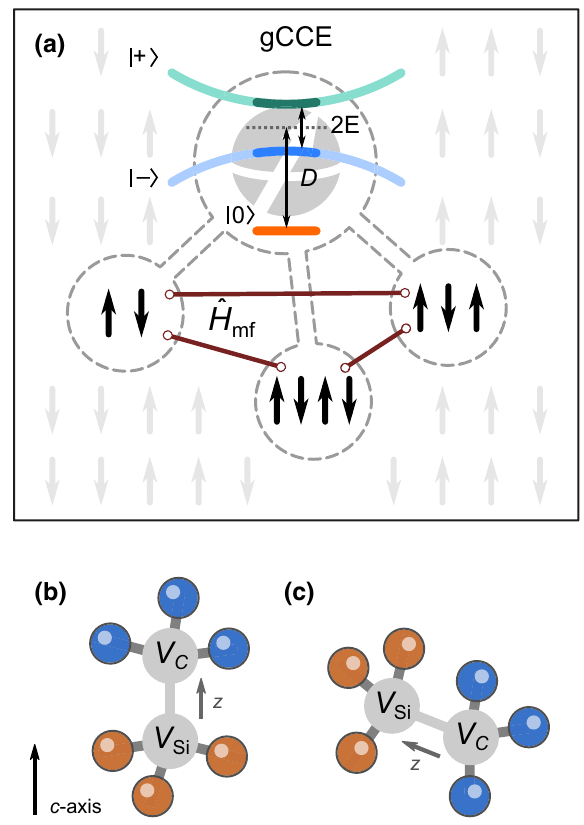
FIG. 1. (a) Schematic representation of the cluster-correlation expansion method used in this work (denoted as gCCE). Each cluster includes the central spin levels (denoted as |+(cid:2) , |−(cid:2) , and | 0 (cid:2) for spin 1 with nonzero longitudinal D and transverse E zero- field splitting). The interactions between clusters are treated at the mean-field level ( ˆ H mf ), using Monte Carlo sampling of bath states. (b) Schematic representation of the axial kk divacancy. (c) Schematic representation of the basal kh